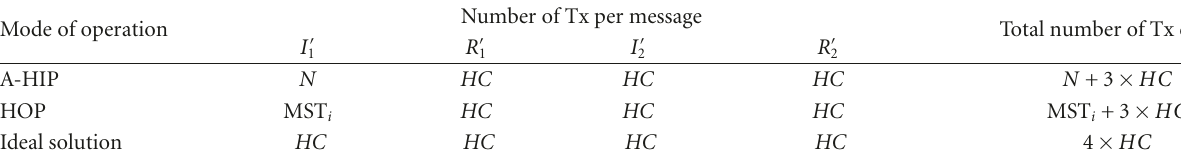
Table 1: Packet overhead introduced at session startup.